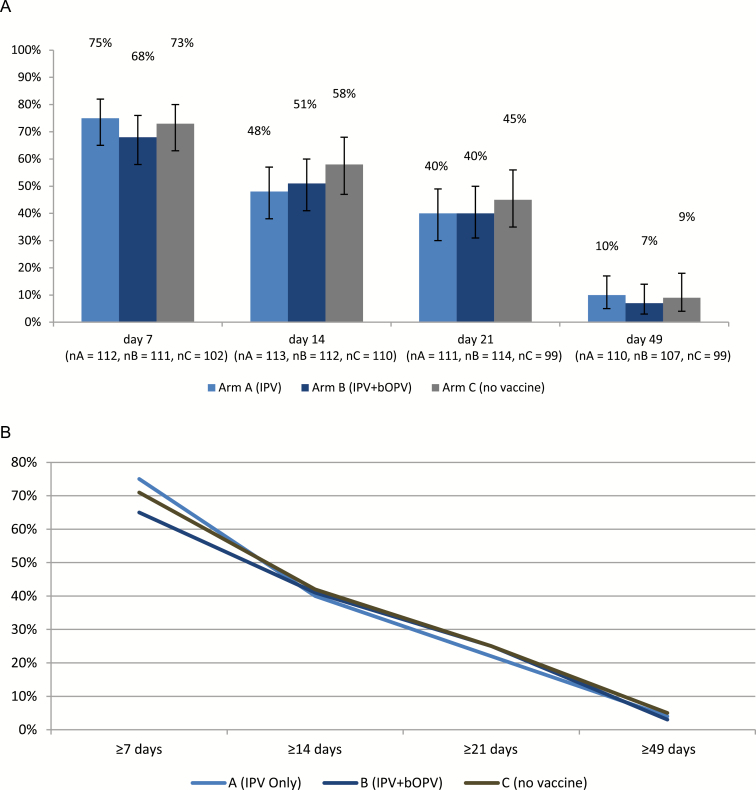
Excretion of PV2 following challenge with tOPV. A, Proportion of children shedding PV2 at each visit post–tOPV challenge. B, Duration of excretion of PV2 post–tOPV challenge (expressed as % children with uninterrupted excretion of type specific poliovirus for at least 7, 14, 21 or 49 days). Abbreviations: bOPV, bivalent oral poliovirus vaccine; IPV, inactivated poliovirus vaccine; PV2, polyvirus type 2; tOPV, trivalent oral poliovirus vaccine.